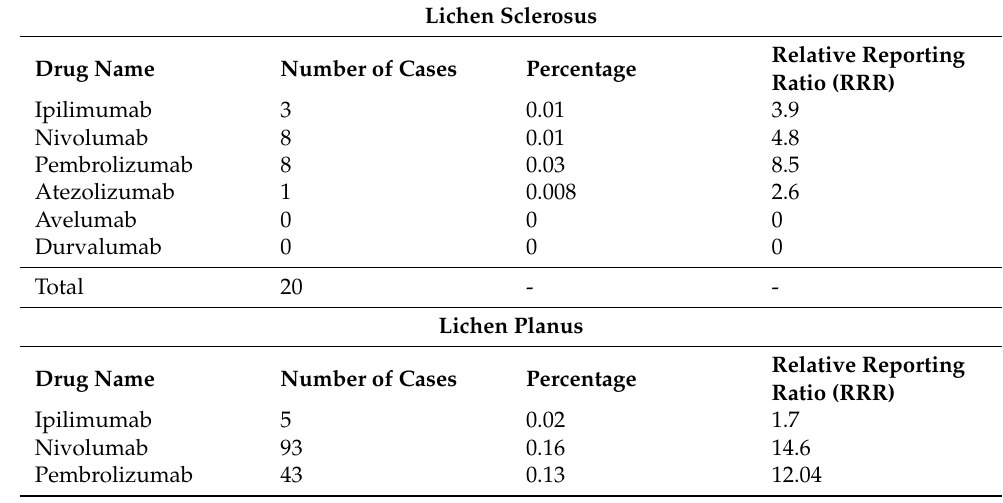
Table 4. FAERS database, relative reporting ratio